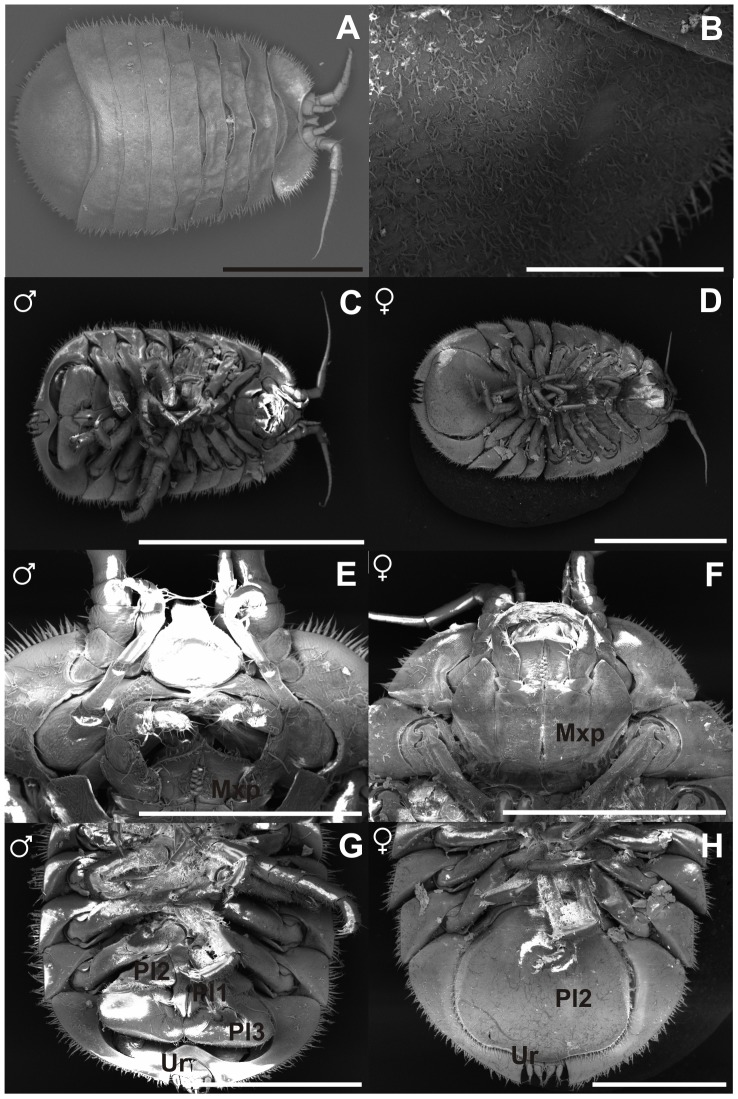
Paratypes NHMUK 2014.340-345, SEM.A) male, dorsal overview, scale – 1 mm, B) male, dorsal setae, scale − 0.3 mm, C) male, ventral overview, scale − 2 mm, D) female, ventral overview, scale − 2 mm, E) male, ventral view, head, maxilliped, scale − 0.5 mm, F) female, ventral overview, head, maxilliped, scale − 1 mm, G) male, ventral view, pleopods 1, 2 and 3, uropod, scale − 1 mm, H) female, ventral view, pleopod 2, uropod, scale − 2 mm